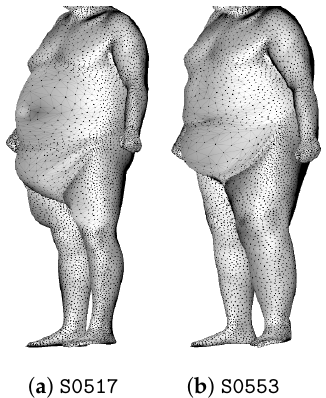
Figure 19. The two individuals of cluster C 1